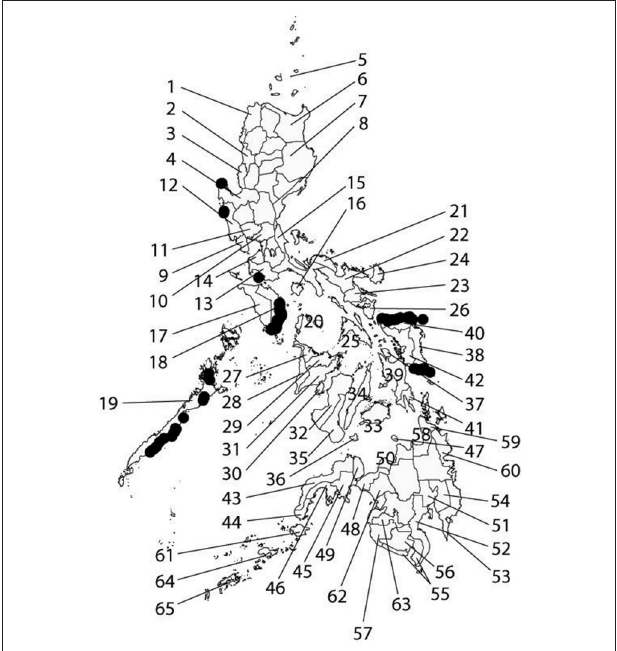
FIGURE 1 | Map showing sources of provincial municipal fish catch data (numbers), and fisher interview sites (dark circles). List of provinces with their corresponding number codes are listed in Table